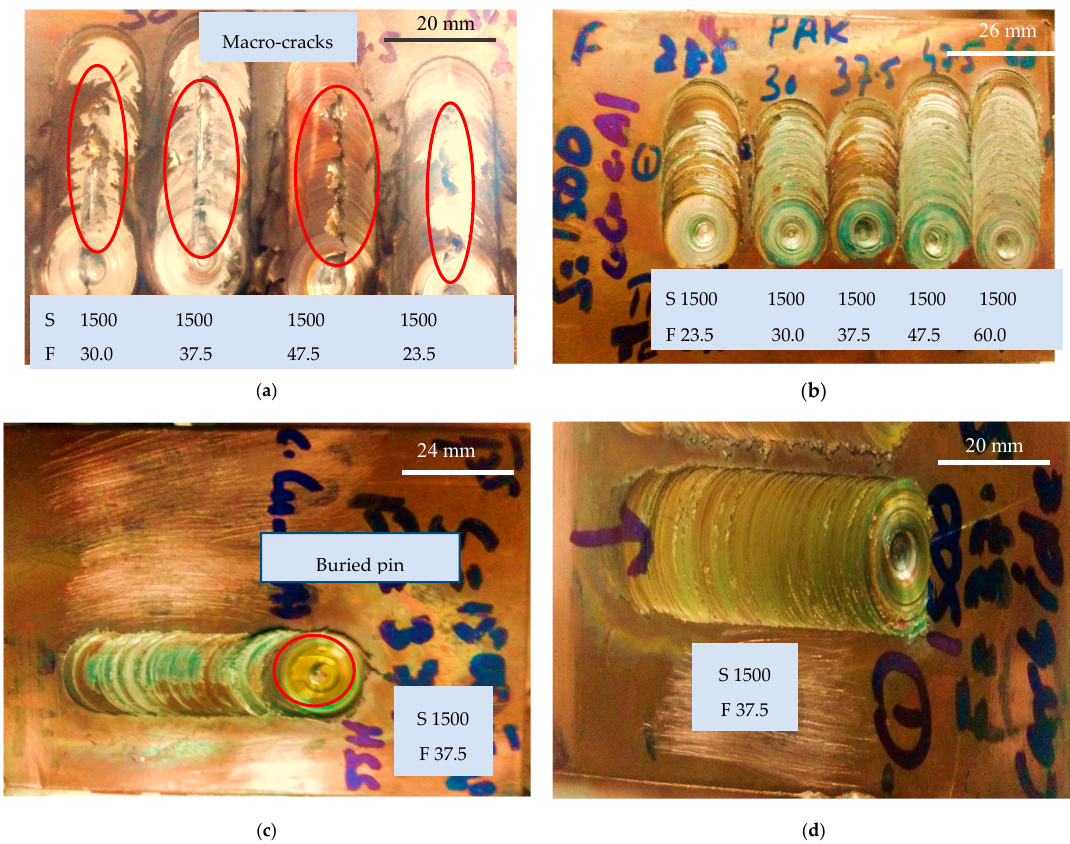
Figure 7. 1060Al-Cu lap joints produced; HSCo ( a ) tapered-pin tool, ( b , c ) square-pin tool, and ( d ) tungsten carbide (WC) square-pin tool.